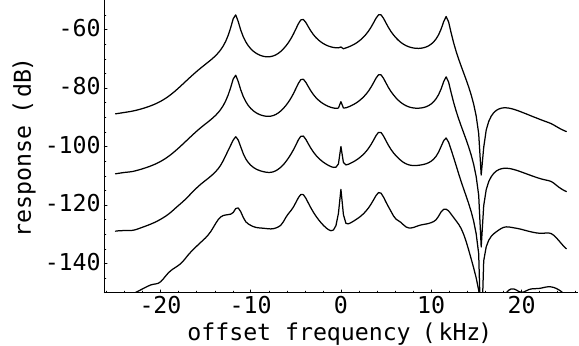
FIG. 11. Simulated beam response functions T 9 55 , T 18 55 , T 36 55 , T 55 55 , and T 135 55 (top to bottom) for a fully stretched 500 mA bunch in the VUV ring. Realistically detuned main- cavity and harmonic-cavity impedances are included in the simulation. The vertical scale has an arbitrary scale factor. Machine parameters are given in Table I.